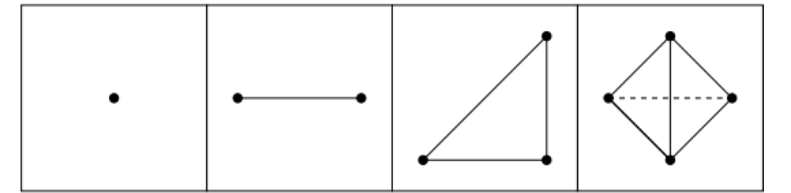
Figure 9. Ref. [19] 0-simplex, 1-simplex, 2-simplex,